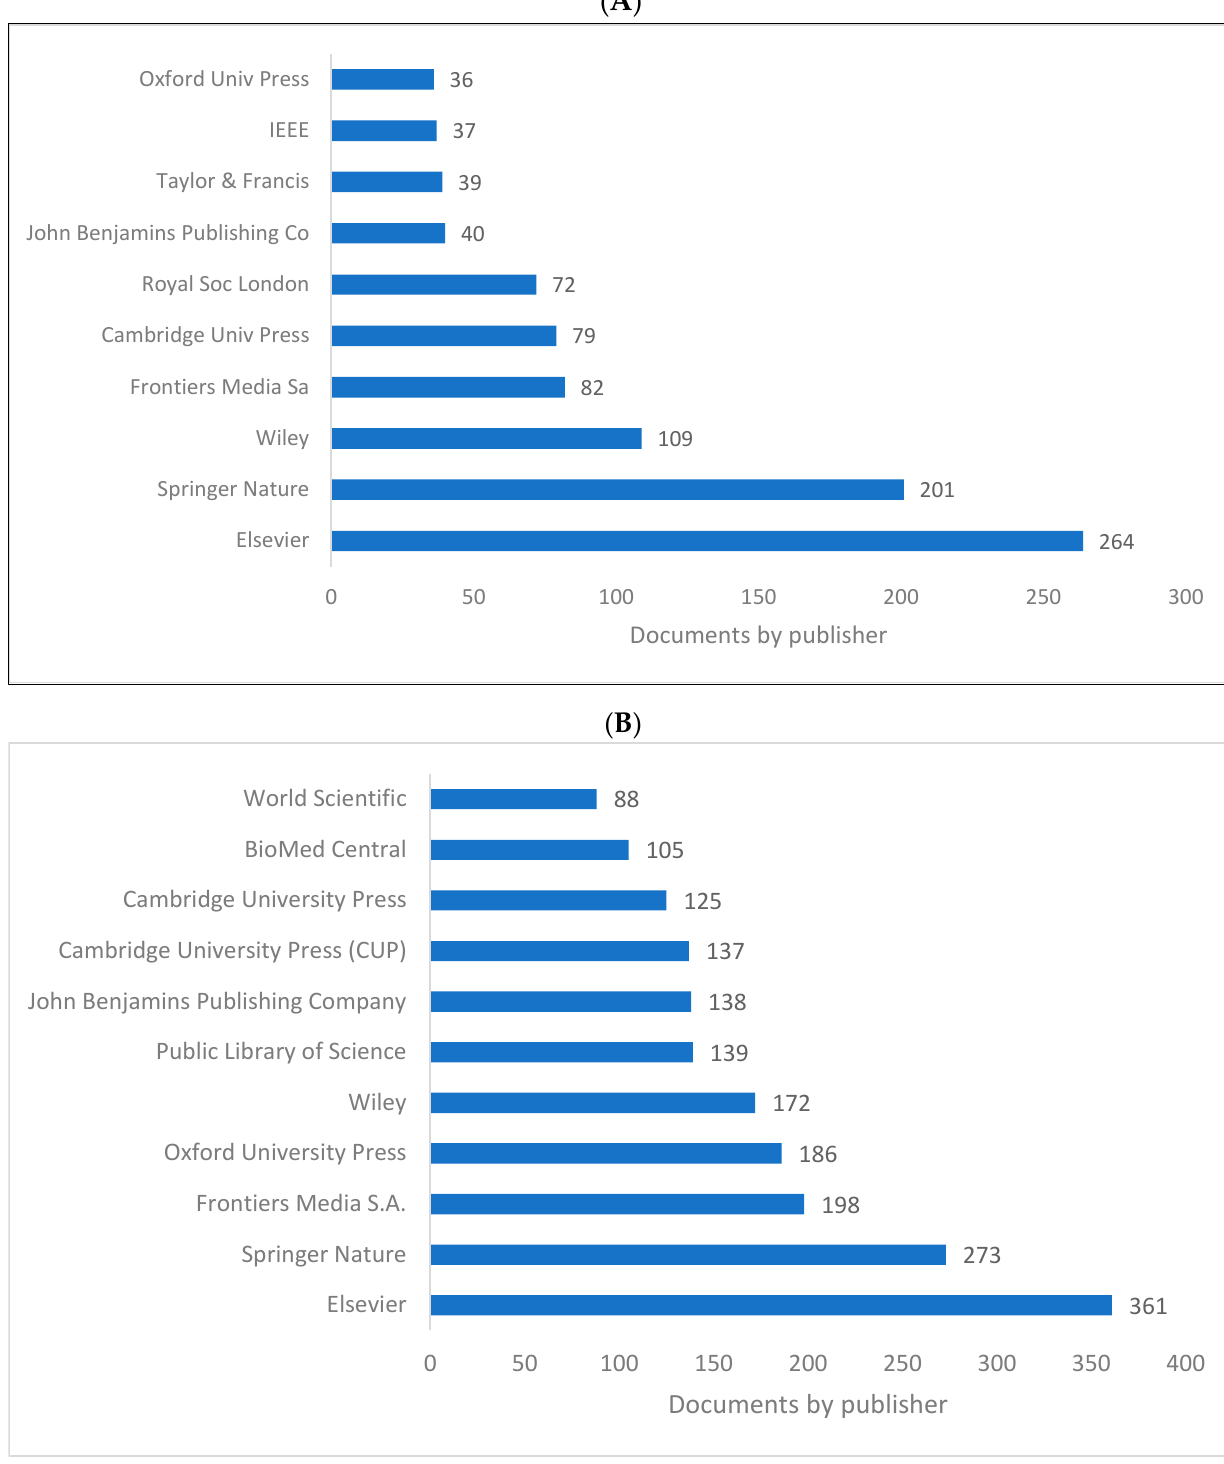
Figure 5. Knowledge production size in biolinguistics by publisher. ( A ) (WOS), ( B ) (Lens).